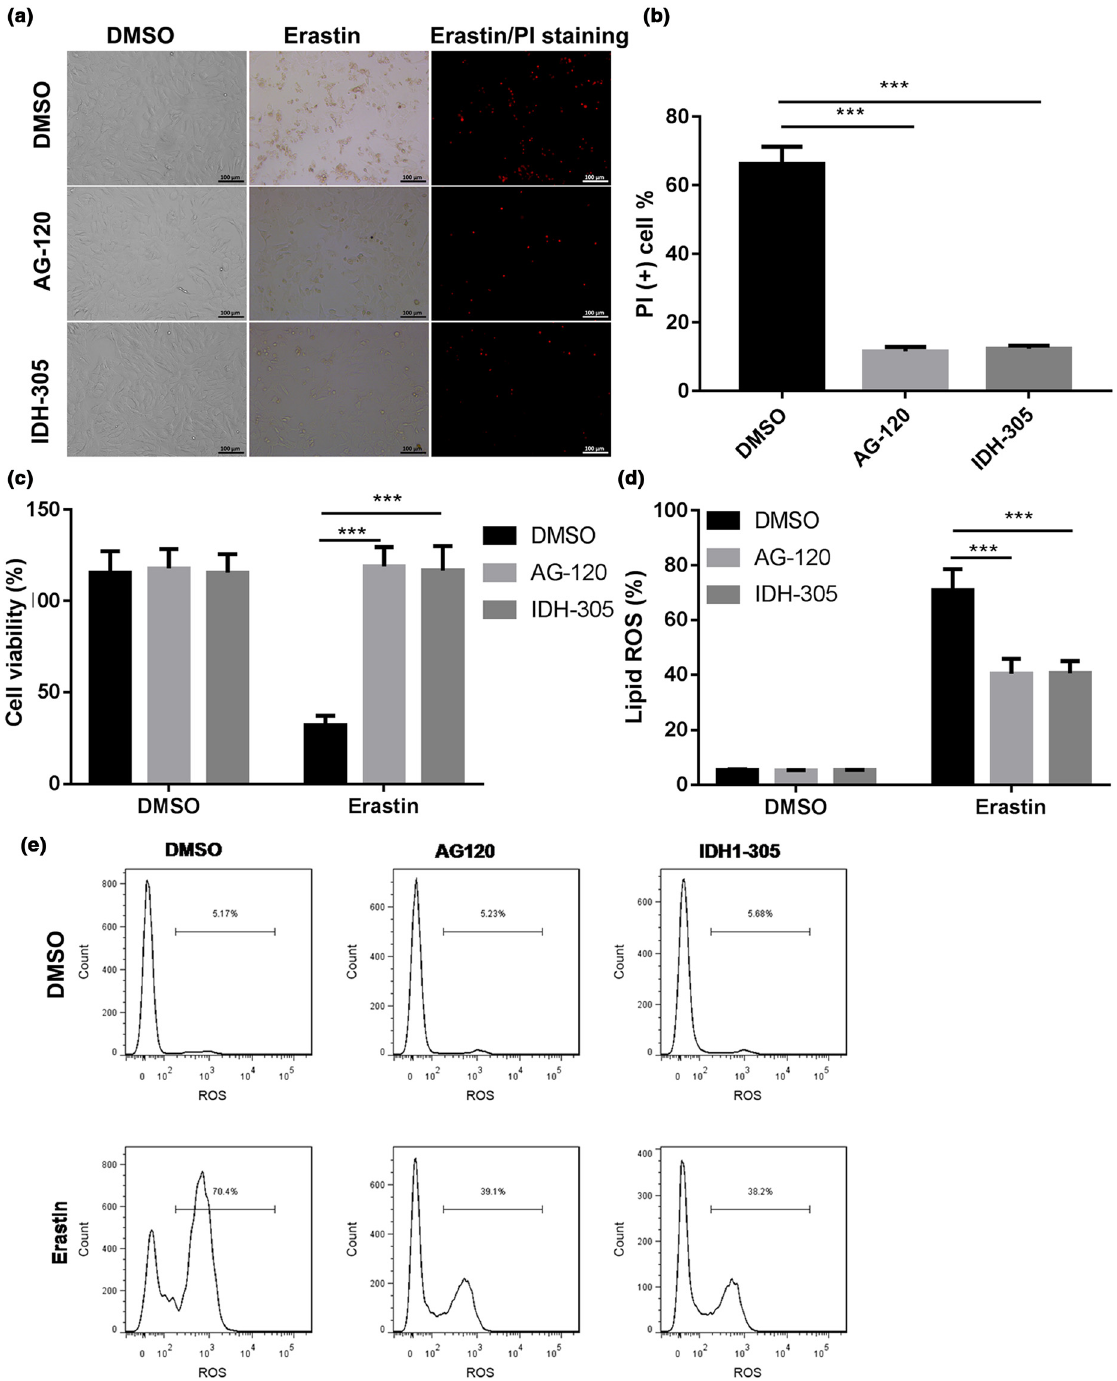
Figure 2: Inhibitors of IDH1 mutation reversed its e ff ects on erastin - induced ferroptosis in cholangiocarcinoma RBE cell line. Current targeted inhibitors of IDH1 ( AG120 and IDH305 ) were administrated into IDH1 R132C mutation cell line with erastin and DMSO treatment, and ( a ) cells were microscopically photographed. ( b ) The number of PI - positive cells was statistically quanti fi ed. ( c ) The trypan blue staining assay was used to determine the e ff ects of AG120 or IDH305 on the cell viability. ( d ) The e ff ects of AG120 or IDH305 on the lipid ROS levels were determined by using fl ow cytometer, and ( d and e ) statistically quanti fi ed. *** p < 0.001 vs DMSO treatment